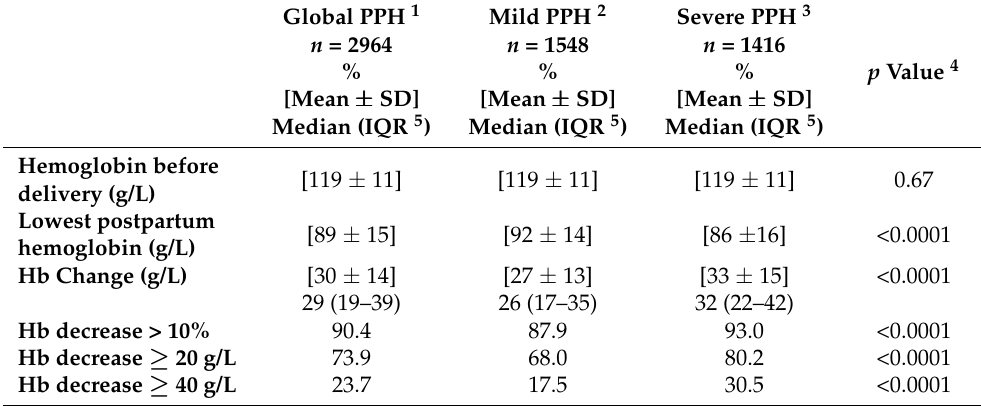
Table 2. Values of hemoglobin decrease, globally and by PPH